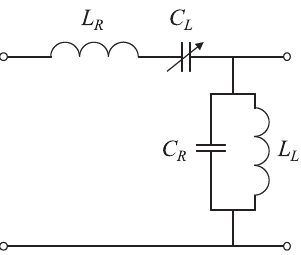
Fig. 5. Equivalent circuit model for the ideal CRLH transmis-